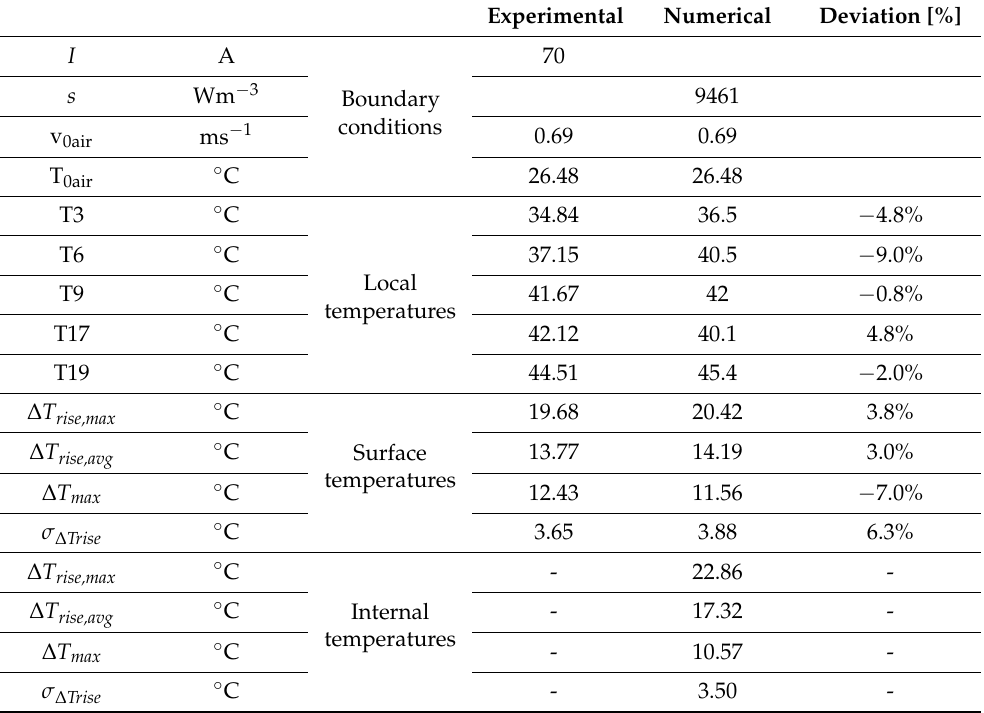
Table 3. Experimental and numerical results.